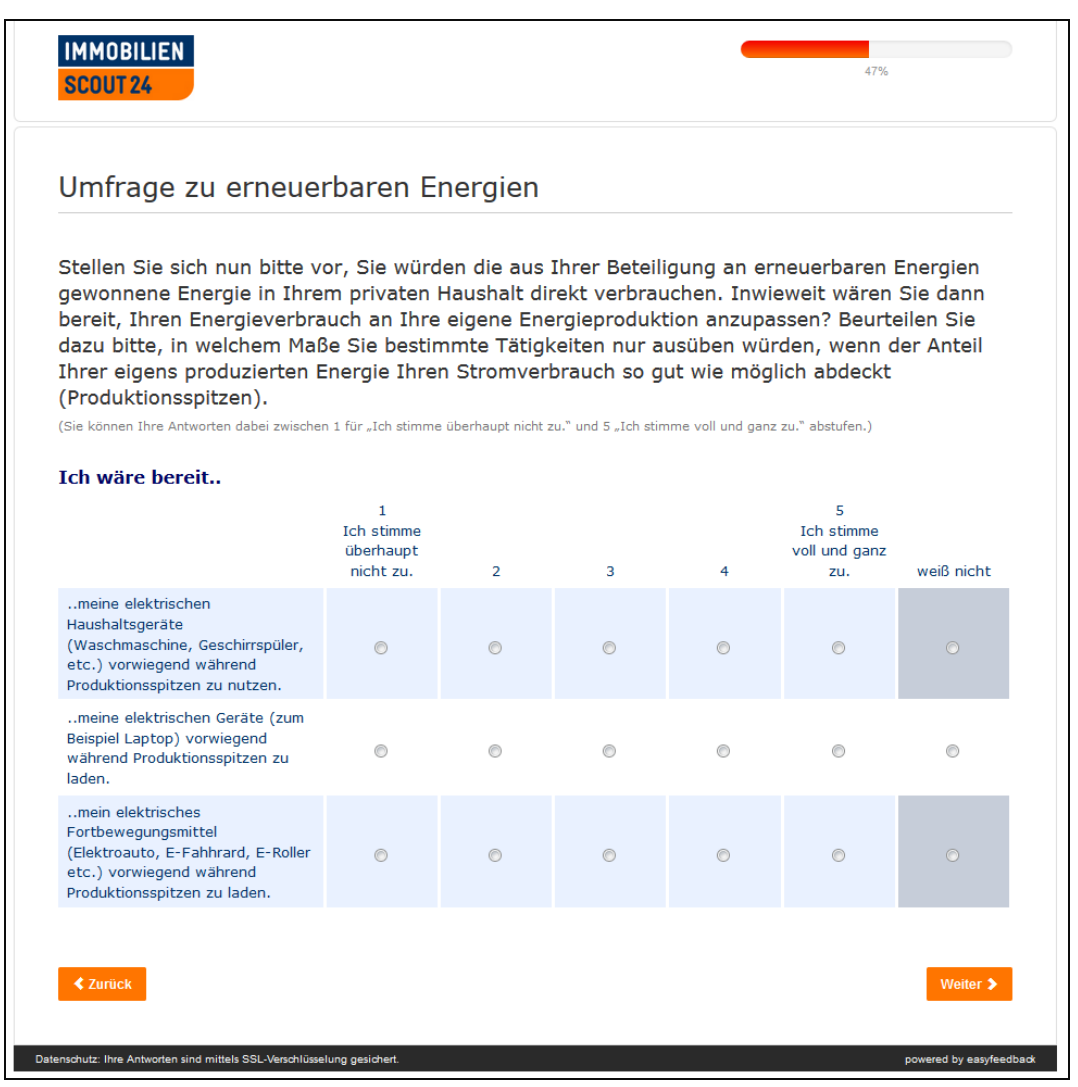
Figure A10. Screenshot of Questionnaire Page 9.